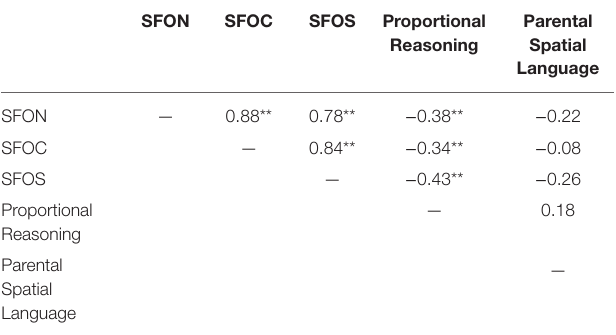
TABLE 7 | Correlation matrix